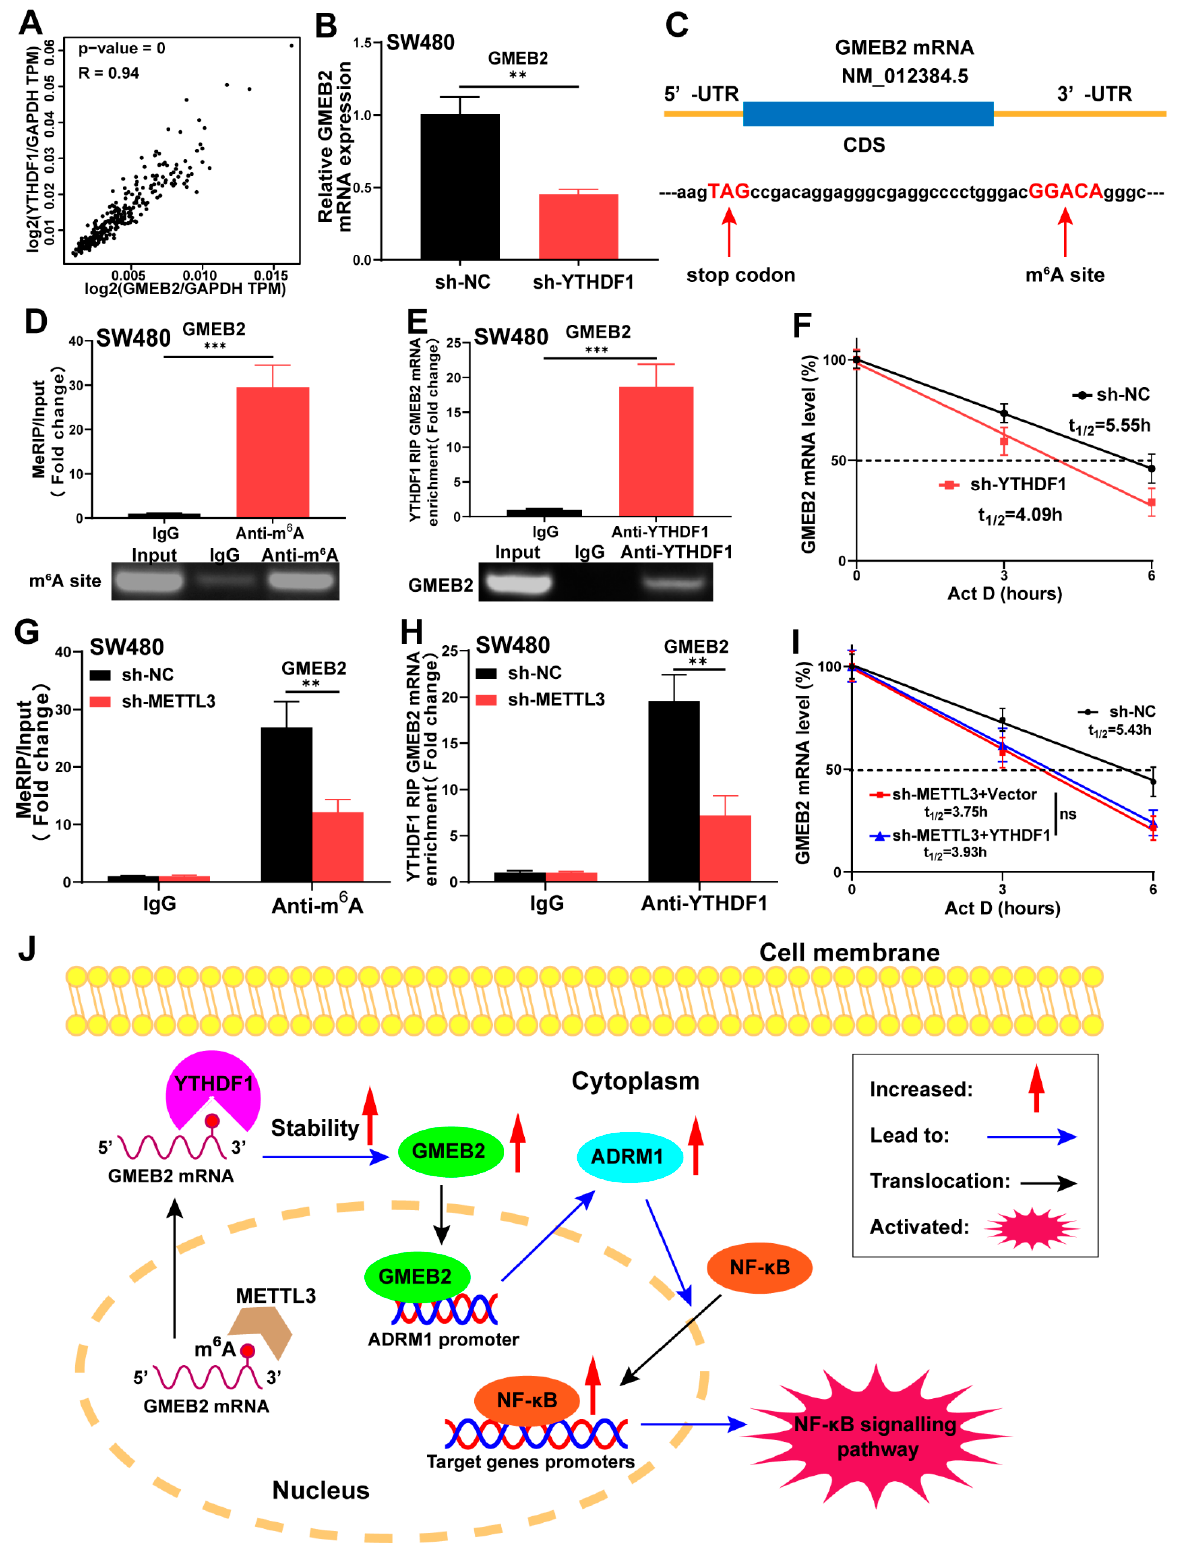
Figure 6. YTHDF1 can stabilize GMEB2 mRNA through recognizing METTL3-mediated m 6 A modification. ( A ) Correlation of mRNA expression between GMEB2 and YTHDF1 in CRC from GEPIA database. ( B ) GMEB2 mRNA expression in the YTHDF1 knockdown SW480 cells (Student’s t -test, ** p < 0.01). ( C ) The m 6 A site in the 3 (cid:48) -UTR of GMEB2 mRNA (near stop codon). ( D )